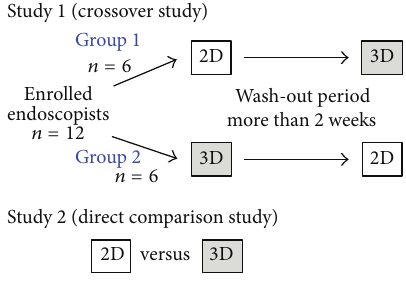
Figure 4: Flow diagram of the study.